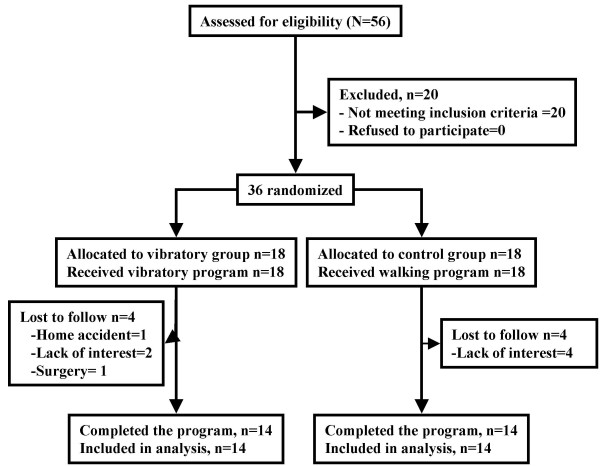
Flow-chart of participants throughout trial.